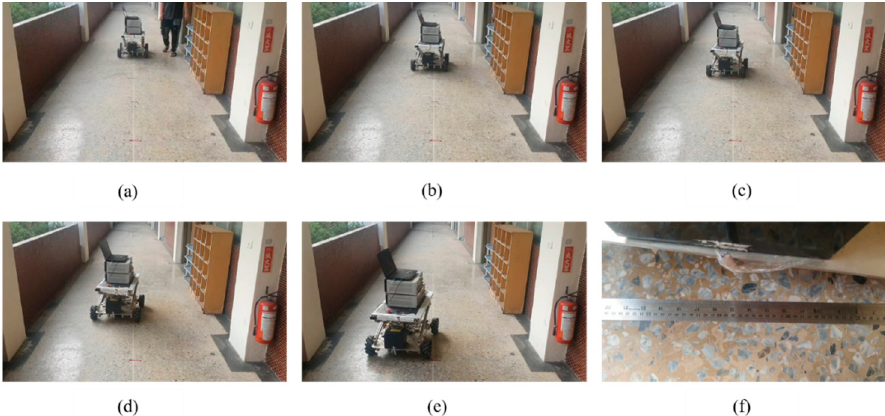
Figure 25. The OMWAGV with a load of 46 kg walking a distance of 400 cm without RLS estima- tion and compensation. ( a ) Starting position, ( b – e ) at middle way, and ( f ) deviation at stop posi- tion.